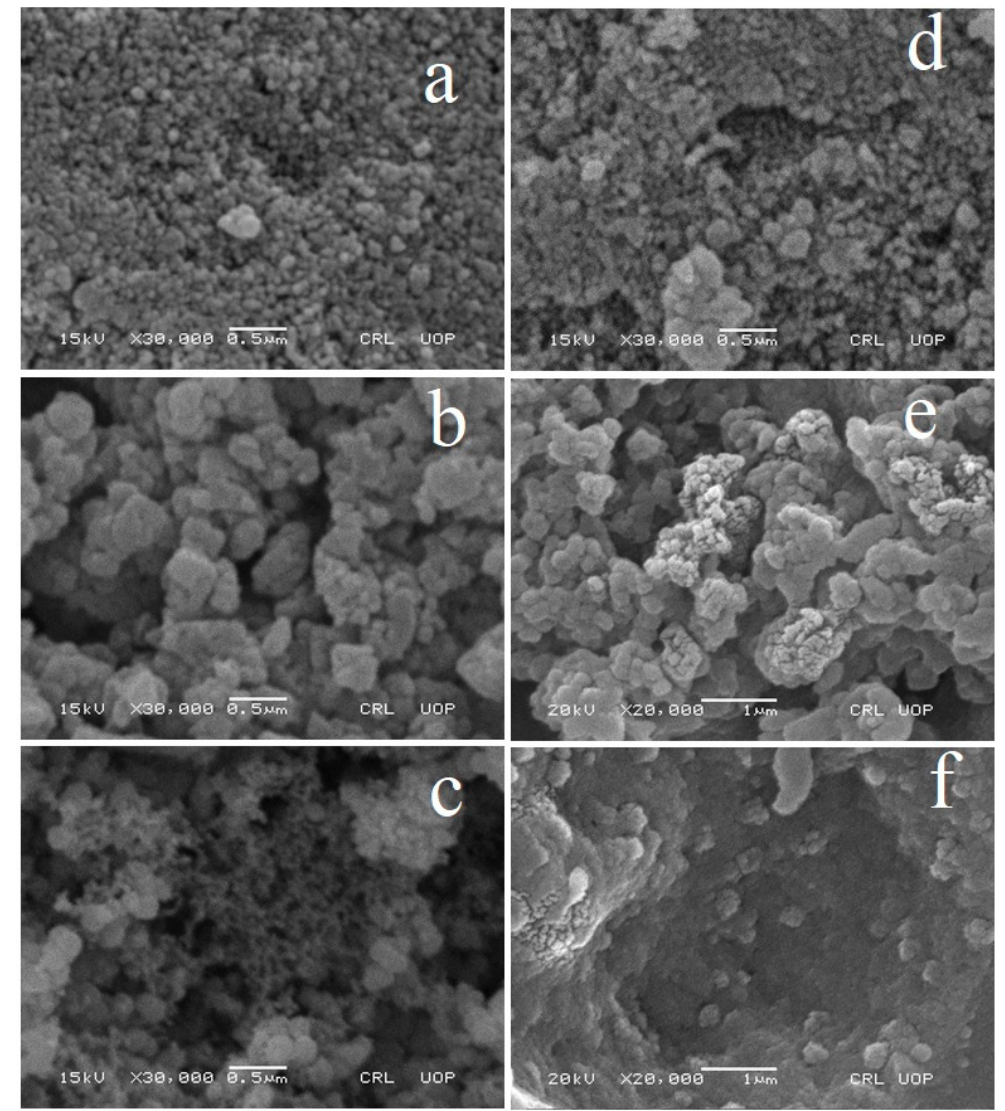
Figure 1. SEM images of Fe 2 O 3 , PANI, and PANI / Fe 2 O 3 composites before ( a , c , e ) and after ( b , d , f ) adsorption of BB3.